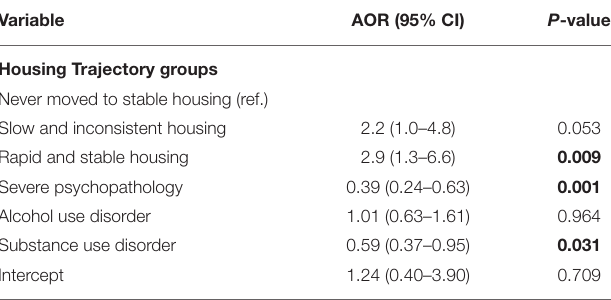
TABLE 3 | Multivariable logistic regressions for consistent food security and housing trajectory groups adjusted for baseline characteristics.